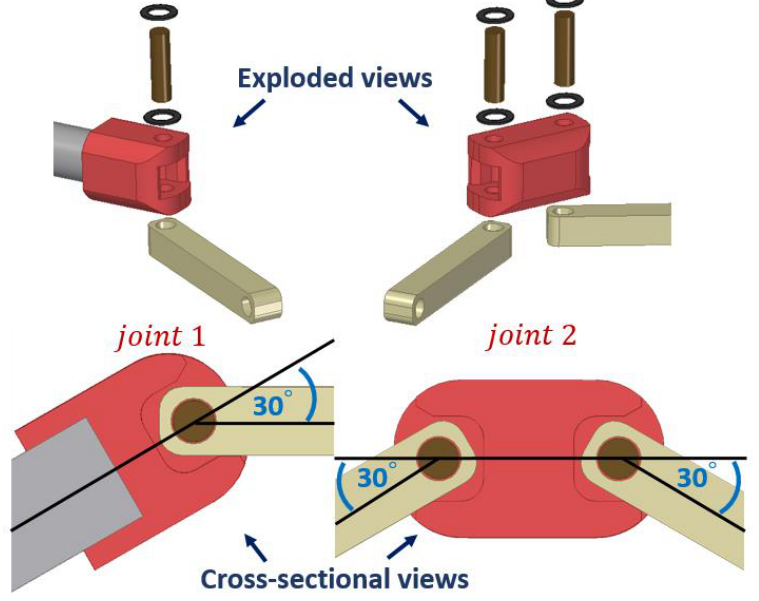
Figure 20. Exploded and cross-sectional views of joint 1 and joint 2, showing the angular joint rotation constraint inherently built in the joint design.